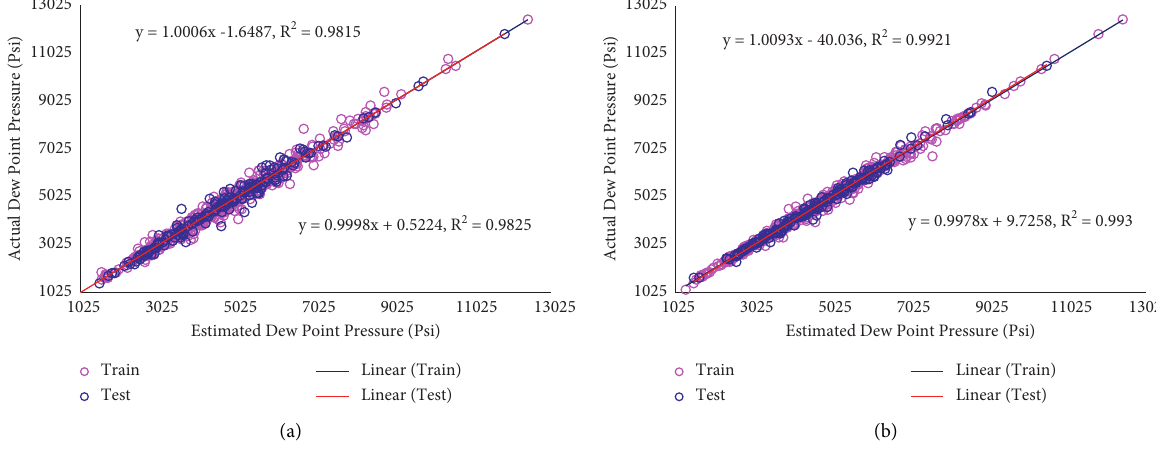
Figure 2: Linear regression on datasets modeled using (a) PSO-ANN and (b) GA-ANN.